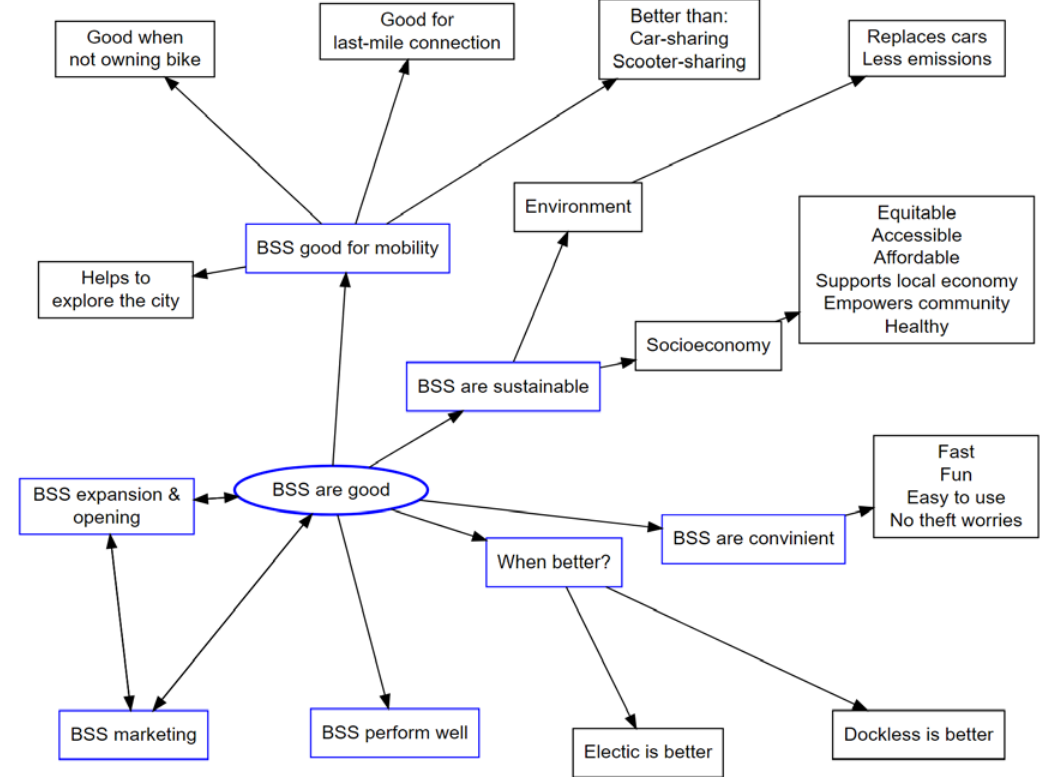
Figure 6. Qualitative topic clustering on strongly positive